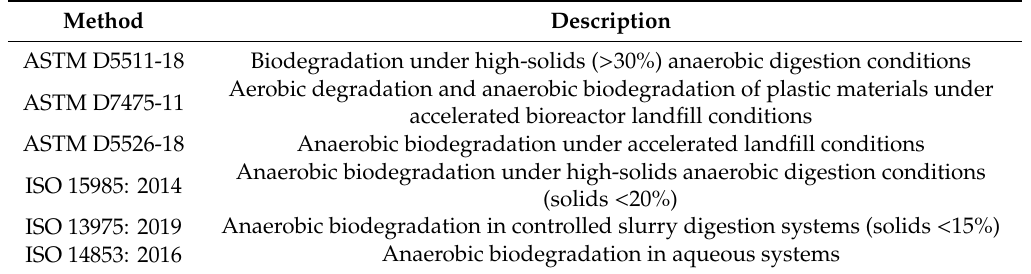
Table 2. Standards for the assessment of biodegradation of plastics in anaerobic